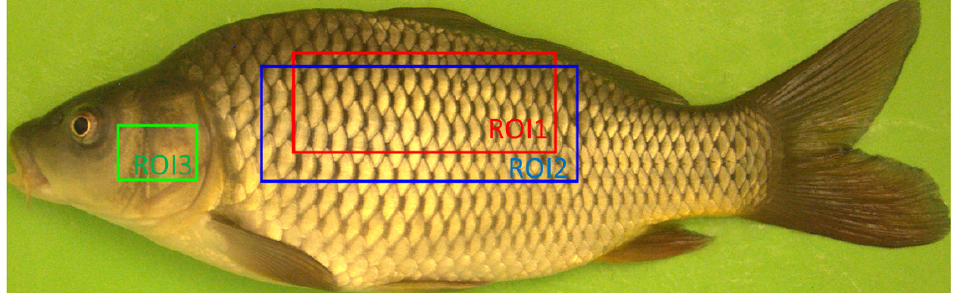
Figure 6. Position of ROIs for carp